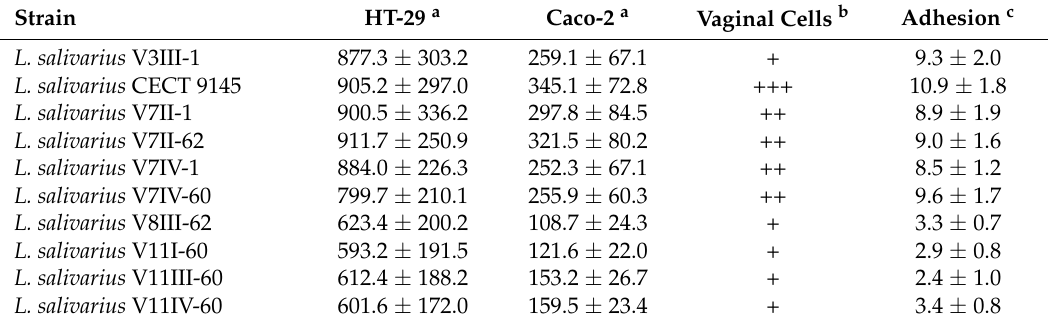
Table 4. The ability of the lactobacilli to adhere to HT-29, Caco-2 and vaginal epithelial cells, and to porcine